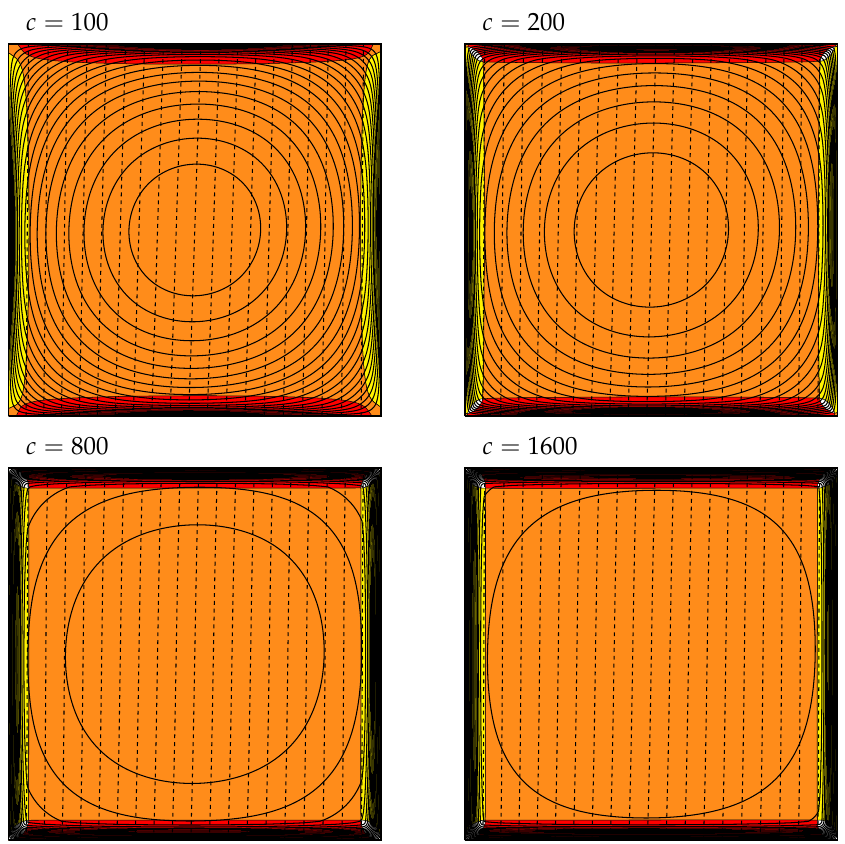
Figure A1. Streamlines (continuous) and isotherms (dashed) for the case Ra = 40, Rb = 9 and A = 1 using the following values of c : 100, 200, 800 and